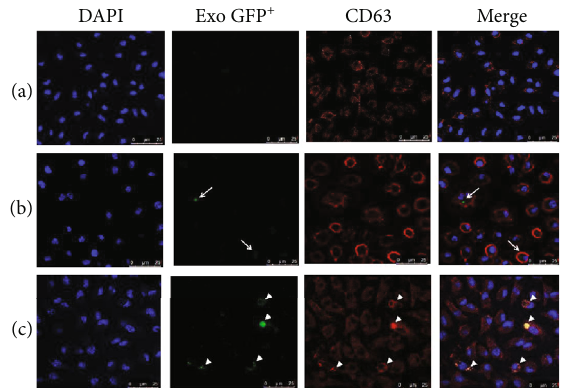
Figure 3: L. mexicana exosomes internalized by BMMs colocalize with CD63. Confocal microscopy of BMMs incubated with green fl uorescent exosomes for 2 or 6h. (a) Nonstimulated BMMs. (b) BMMs after 2h of incubation with exosomes (10 μ g/mL). Arrows show green exosomes localized in the cytoplasm of BMMs, and CD63 marker is evidenced on the cell membrane. (c) BMMs incubated for 6h with exosomes (10 μ g/mL). Merged image shows yellow staining (arrowheads) as a result of colocalization of CD63 marker and L. mexicana exosomes. DAPI stain shows nuclei in blue, tetraspanin CD63 is stained in red, and exosomes show green staining. The images are representative of two 2 independent